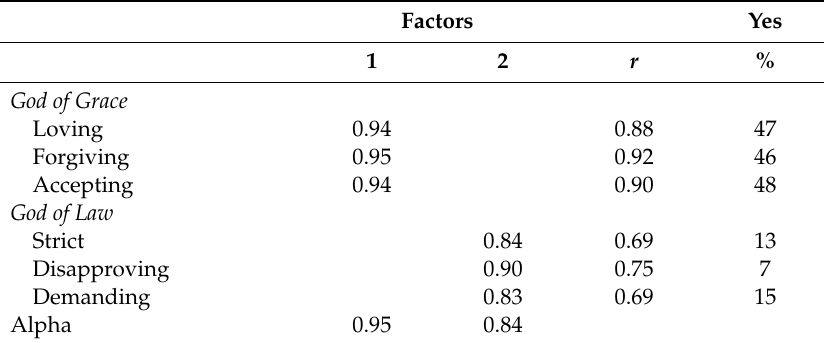
Table 2. New Indices of God images